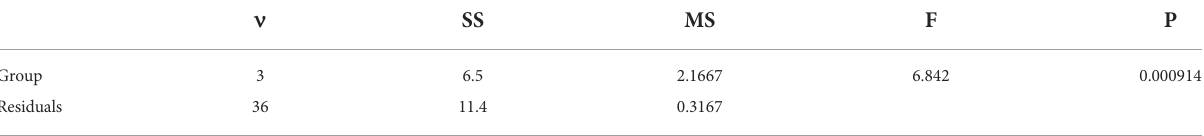
TABLE 3 Results of ANOVA of in fi ltration score. n SS MS